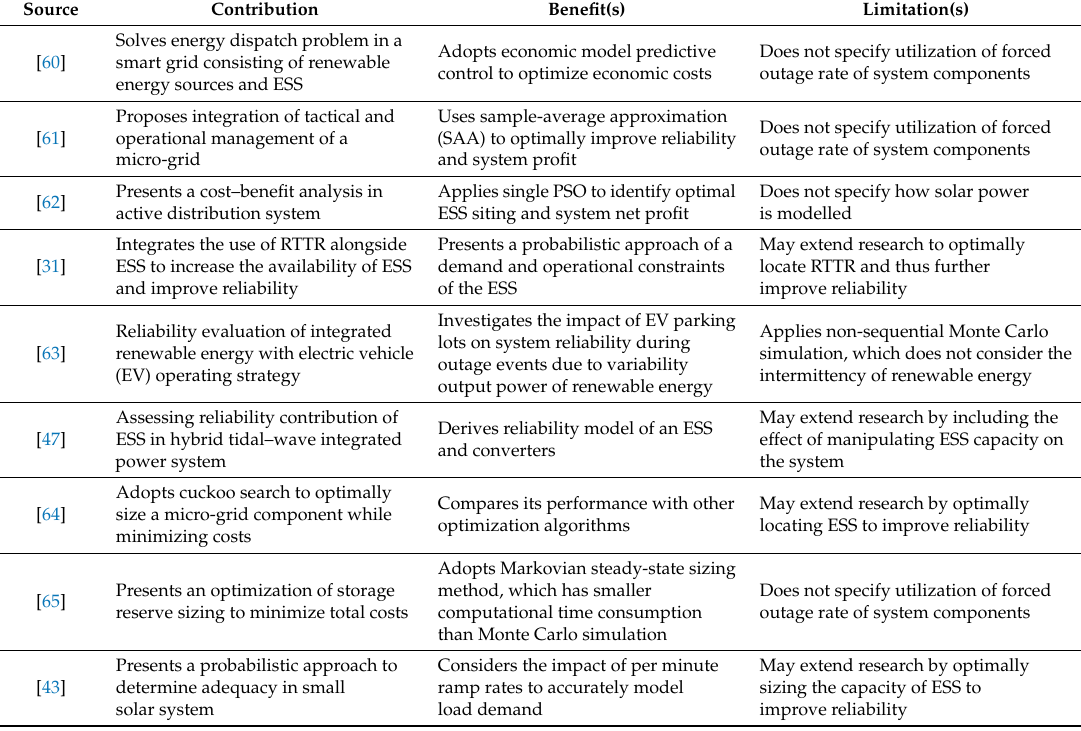
Table 8. Comparison of notable works on impacts of ESS on